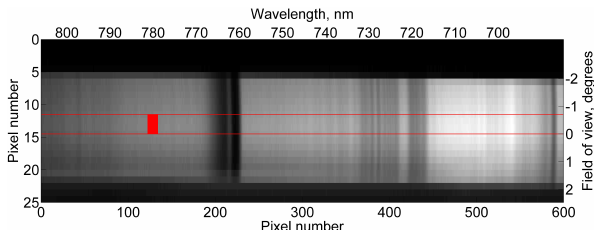
Fig. 2. The CCD image presents a twilight spectral image (685– 800nm) acquired by the spectrometer. Abscissa corresponds to wavelength dimension, ordinate – to spatial dimension. The spatial dimension is shown in degrees, because the distance to the scatter- ing volume varies with the SZAs. Red lines encompass the spatial area where the spectral image was averaged. The red rectangle indi- cates the area where the spectral image was averaged to receive the monochromatic twilight sky intensity for the corresponding time.